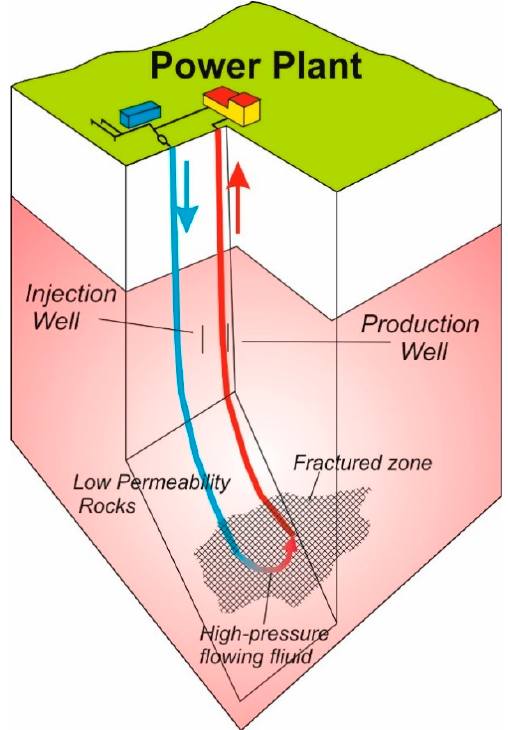
Figure 2. Schematic of a conceptual two-well Enhanced Geothermal System (EGS) in hot dry rock (based on [31]).